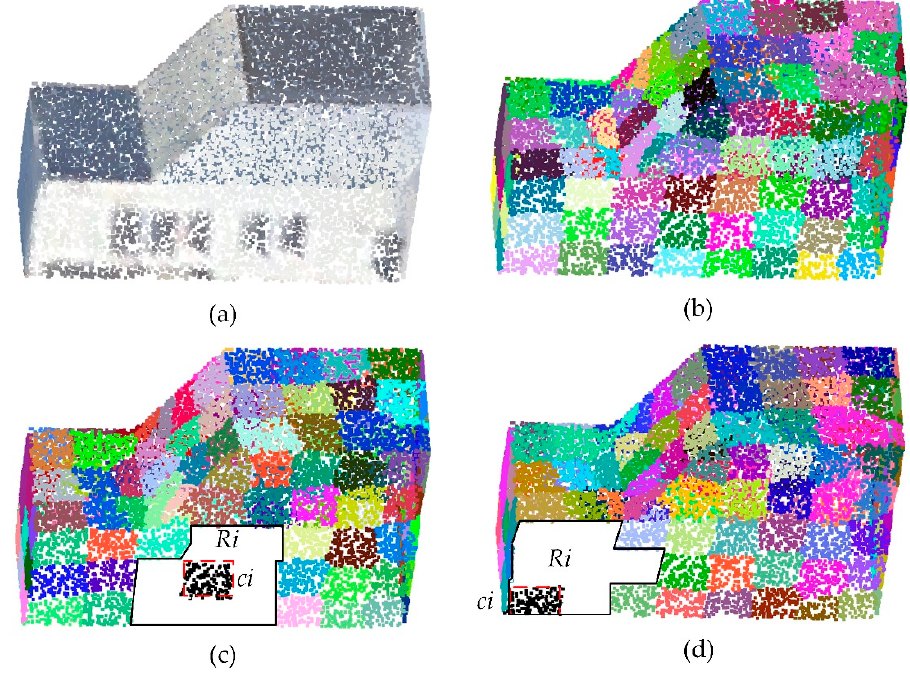
Figure 3. Directional expansion of the maximal support regions. ( a ) Photogrammetric point cloud, ( b ) supervoxels, ( c ) growing region of a supervoxel located in a plane, and ( d ) growing region of a supervoxel located in a sharp feature.